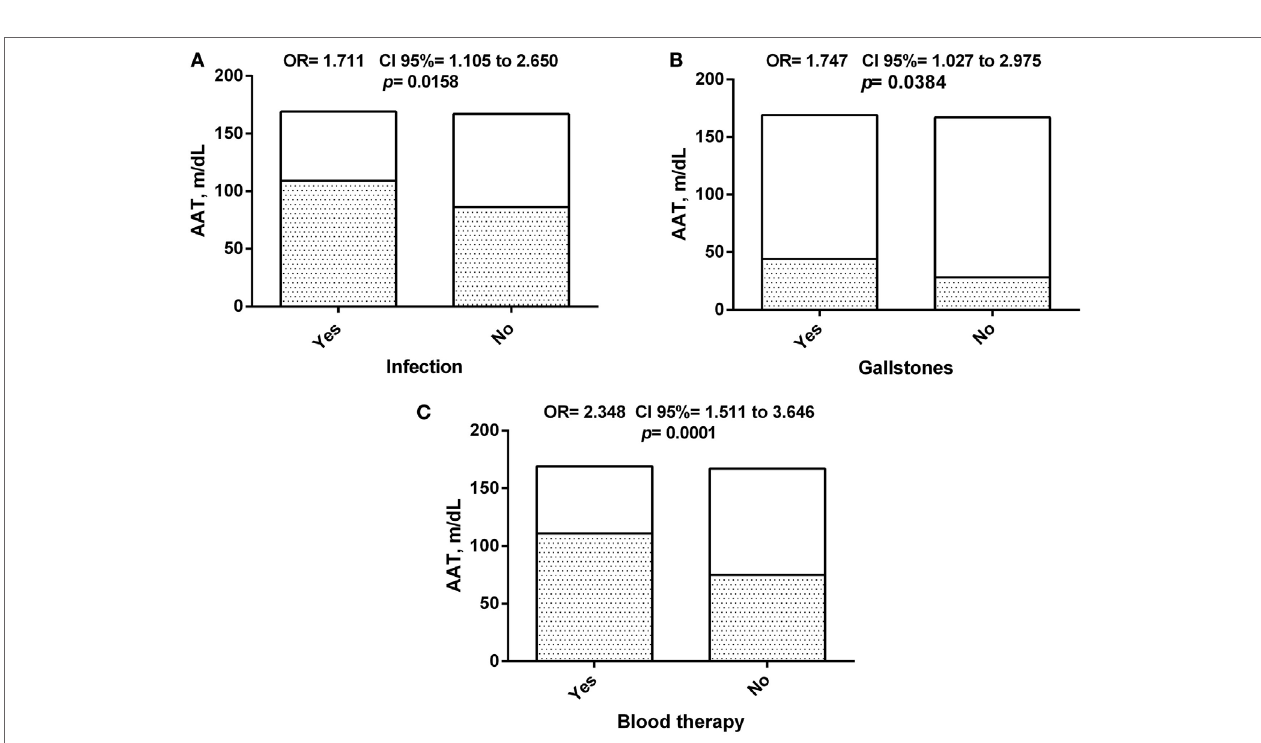
FigUre 6 | Association of alpha-1 antitrypsin (AAT) concentration between sickle cell disease (SCD) patients and clinical history. (a) Association of AAT concentration among SCD patients with history of infection episodes; (b) association of AAT concentration among SCD patients with history of gallstones; (c) association of AAT concentration among SCD patients with history of blood